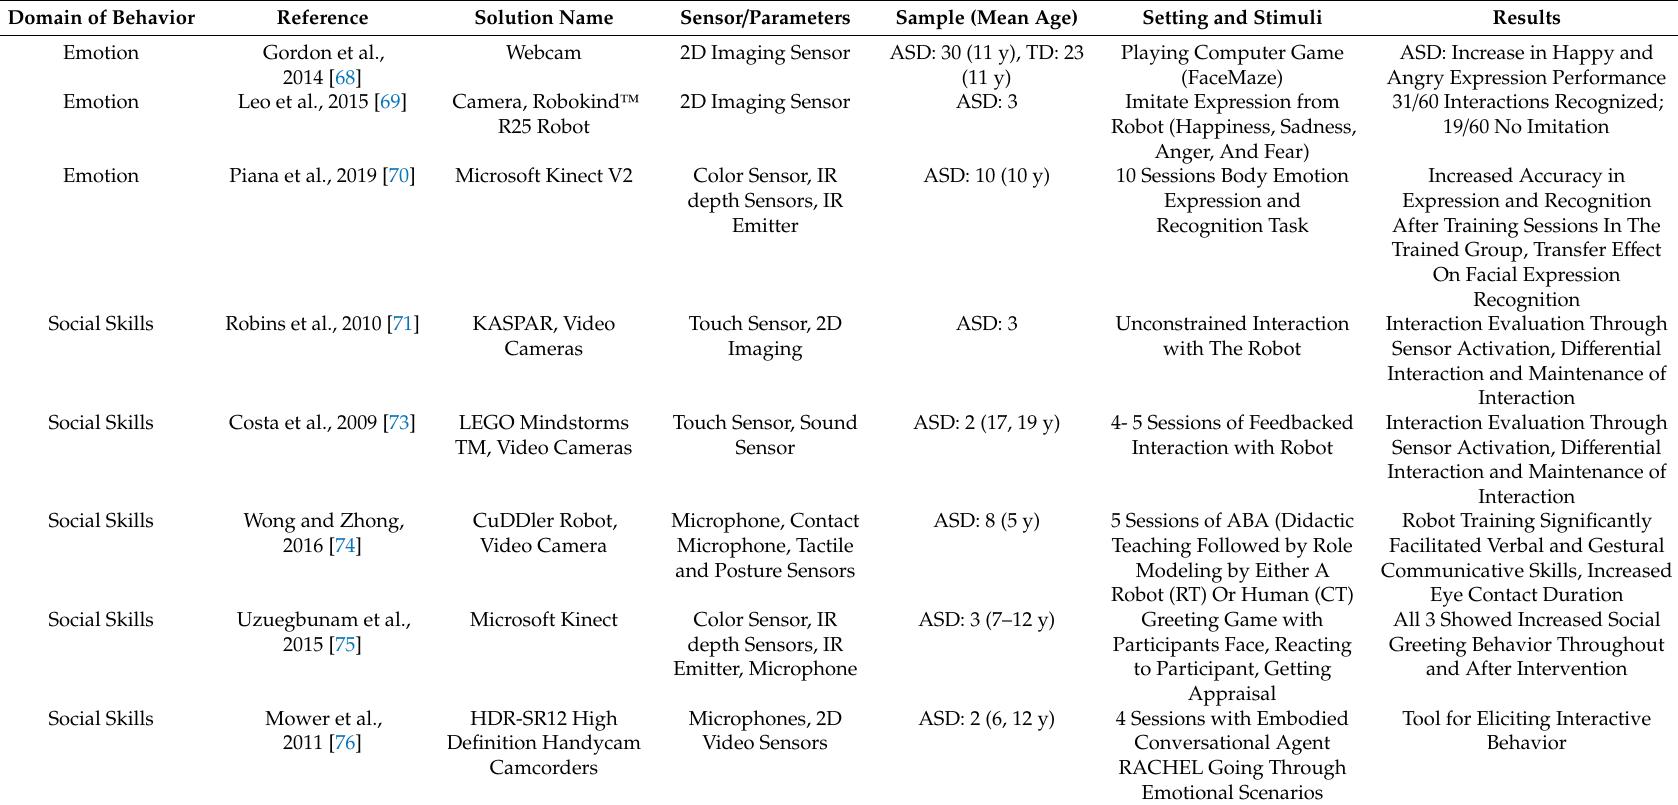
Table 2. Original Articles on Sensor-Based Supporting Interventions in